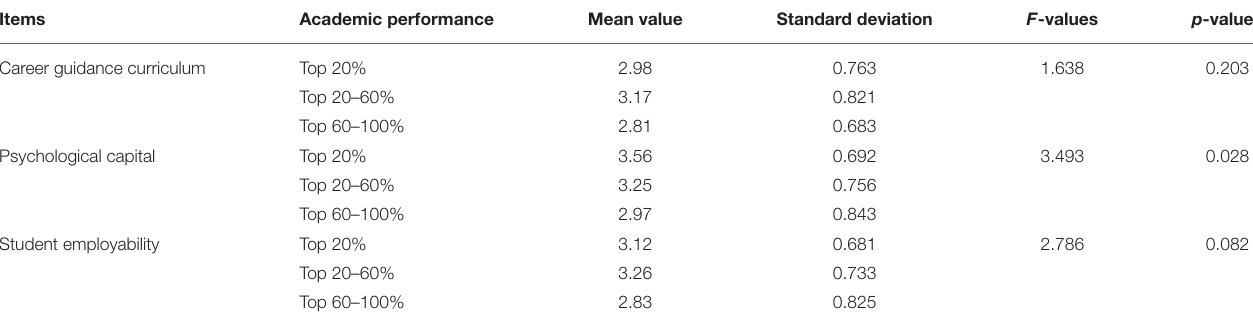
TABLE 7 | Variable analysis of different academic performances. Items